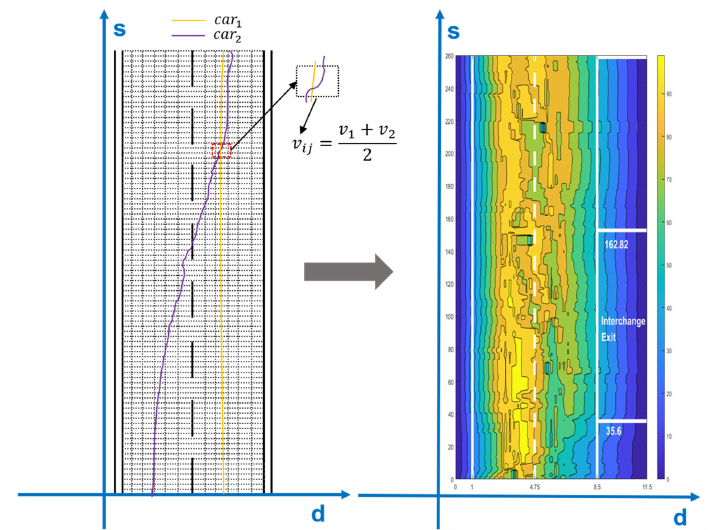
Figure 16. Average speed of vehicles at the exit of the Baomao Expressway.